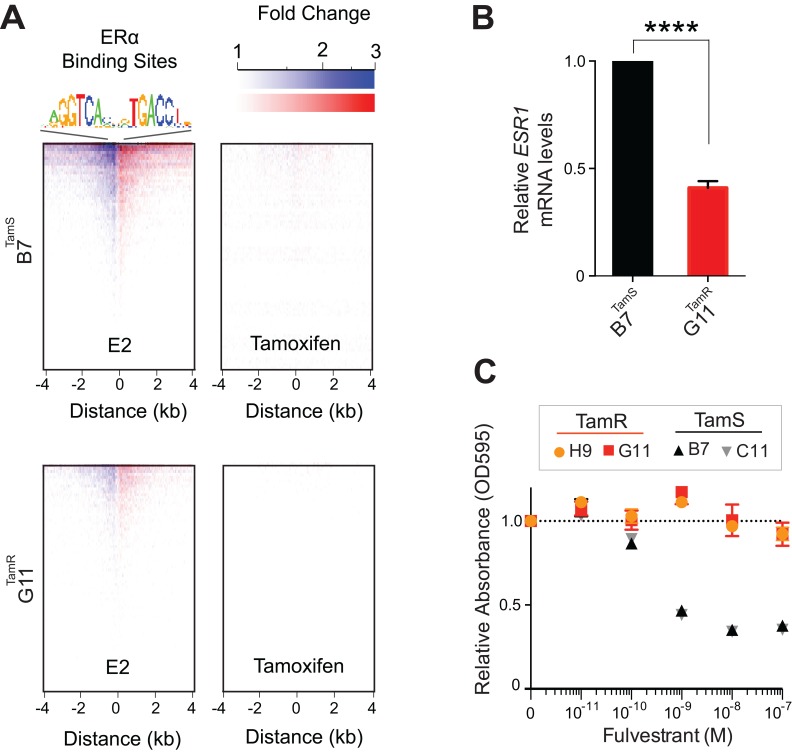
Tamoxifen resistant lines have functional ERα signaling.(a) Heatmap of changes in RNA polymerase abundance following 40 minutes of E2 or tamoxifen treatment near ERα bindings sites in B7TamS and G11TamR cells. (b) ESR1 mRNA expression levels in B7TamS and G11TamR cells. Data are represented as mean ± SEM (n = 3). **** p < 0.0001. (c) Cell viability of TamS and TamR cells upon treatment with 0 (vehicle; DMSO), 10−11, 10−10, 10−9, 10−8, or 10−7 M fulvestrant (ER degrader) for 4 days. Data are represented as mean ± SEM (n = 3).